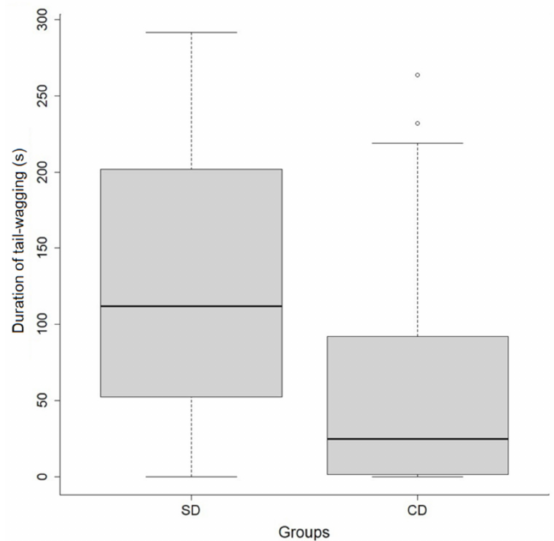
Figure 3. Duration of tail-wagging for shelter dogs (SDs) and companion dogs (CDs) during training sessions. Bold horizontal lines represent medians; gray boxes represent quartiles; thin horizontal lines represent minimum and maximum